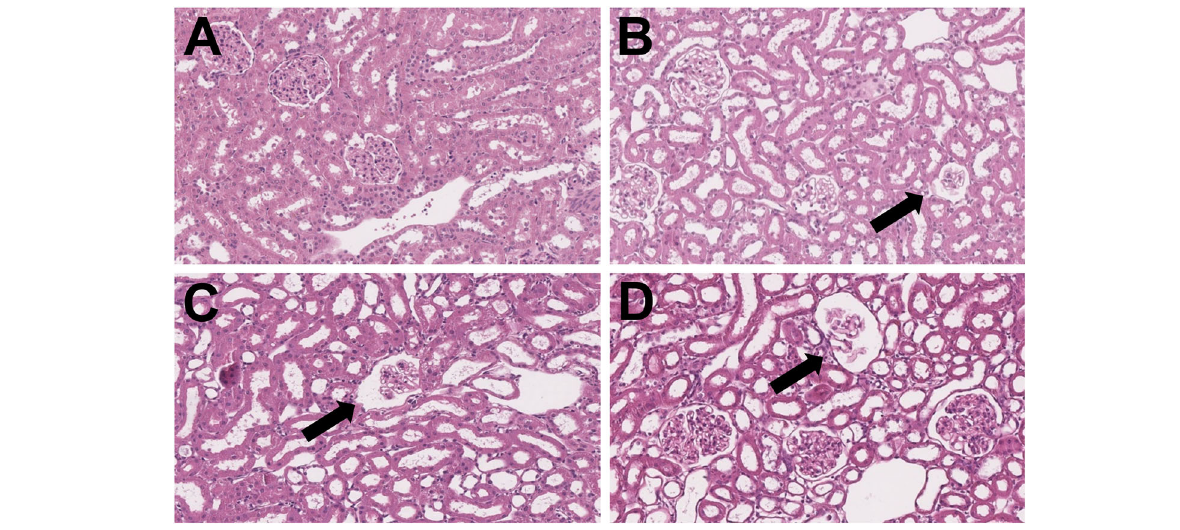
Fig. 3 Microscopic images of the kidneys of an animal in group 1 ( a ), group 2 ( b ), group 3 ( c ) and group 4 ( d ). Tubules appear dilated in all animals, and glomeruli shrinkage was found in most animals (black arrows), except for a small number of animals in group 1 ( a ).